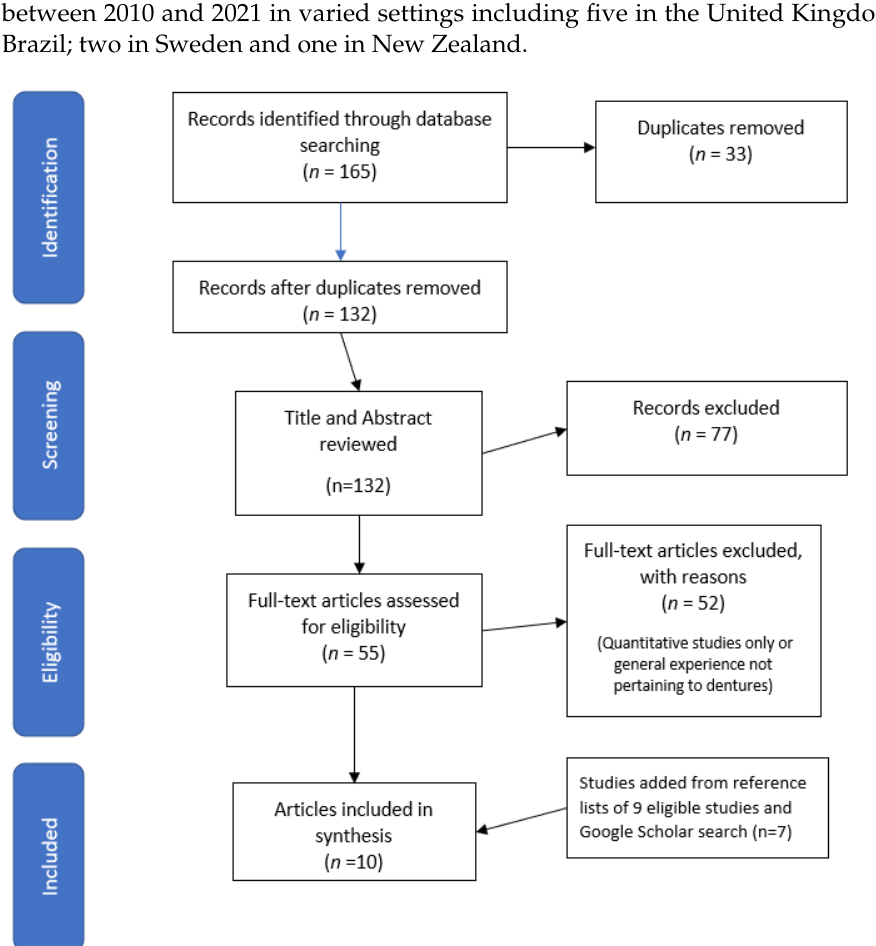
Figure 1 . PRISMA summary of articles identified. Figure 1. PRISMA summary of articles